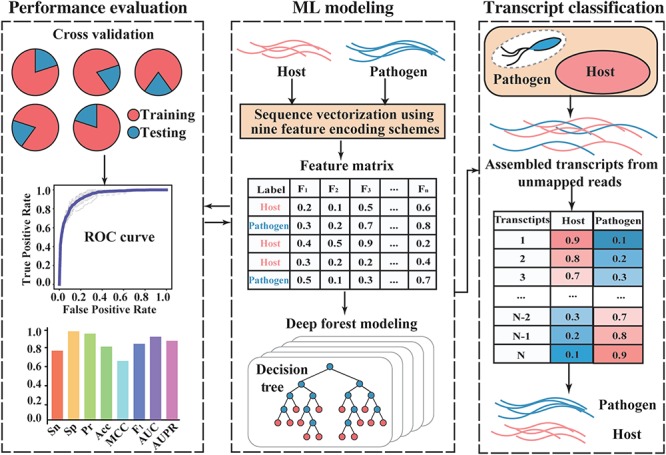
Overview of SAT functional module in CAFU.